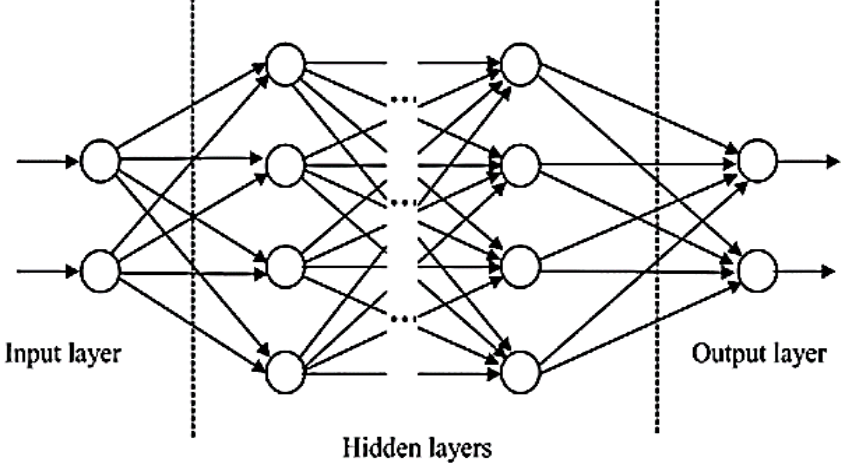
Figure 3. Neural Network schematics. Reprinted with permission from Soteris A. Kalogirou (2001) Copyright 2001 Elsevier Science Ltd. Copyright 2001 Elsevier Science